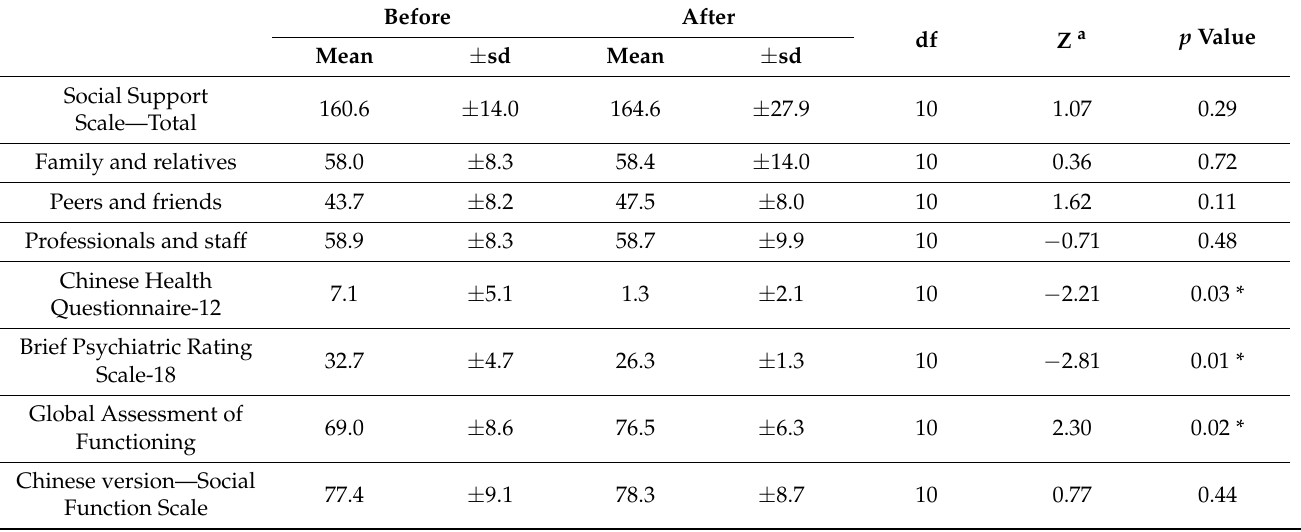
Table 5. The measured outcomes among trainees before and after the whole training course ( n = 11).